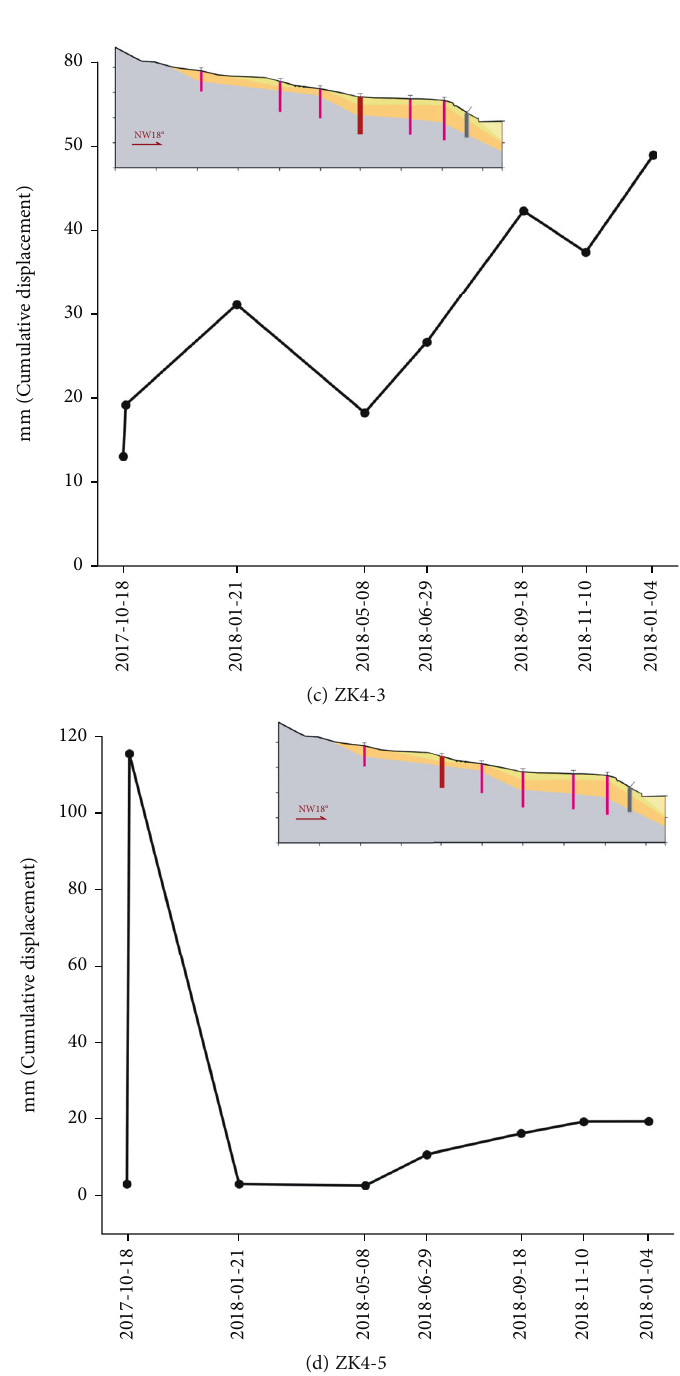
Figure 15: Cumulative displacement-time curves at 0.5m depth of ZK4-1, ZK4-2, ZK4-3, and ZK4-5